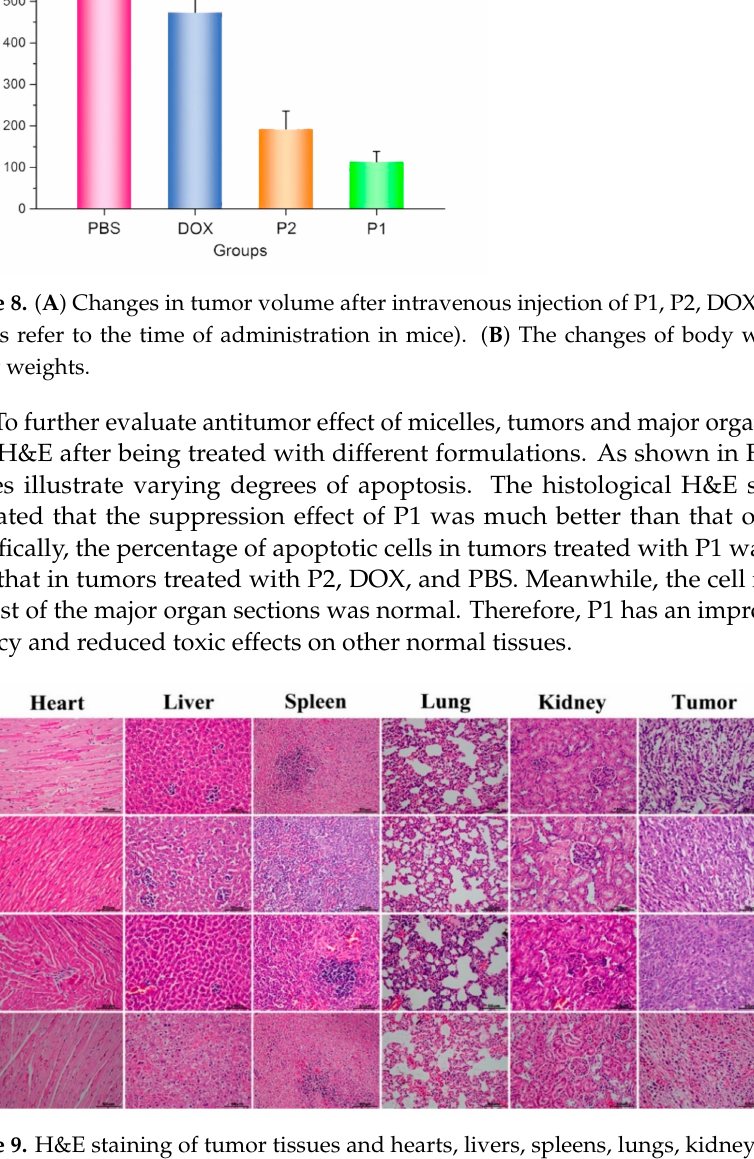
Figure 9. H&E staining of tumor tissues and hearts, livers, spleens, lungs, kidneys after treatment with various formulations (Scale bar: 50 µ